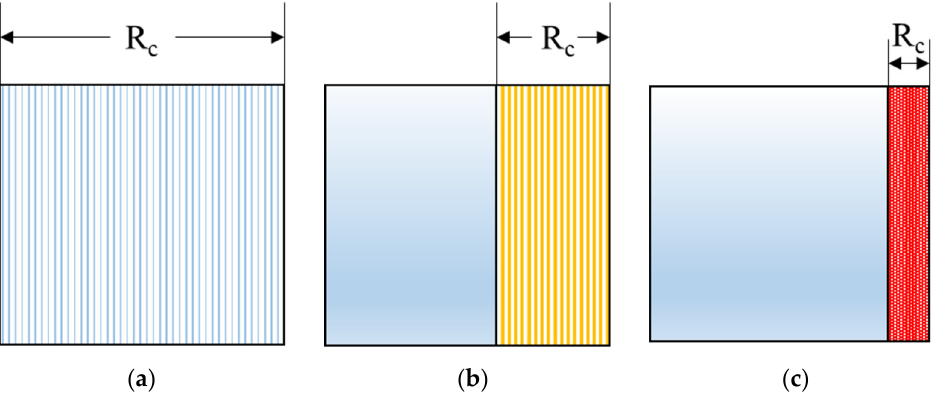
Figure 1. Three deformation modes of foam material under different loading rates [41]. R c represents the compressed part. ( a ) Homogeneous mode: the stress values on the proximal and distal surfaces of the specimen are equal and the strain is distributed uniformly along the specimen length. ( b ) Transitional models: the impacted foam collapsed and the proximal end has not densified. ( c ) Shock mode: the impacted foam rapidly collapsed and densified close to the proximal end.